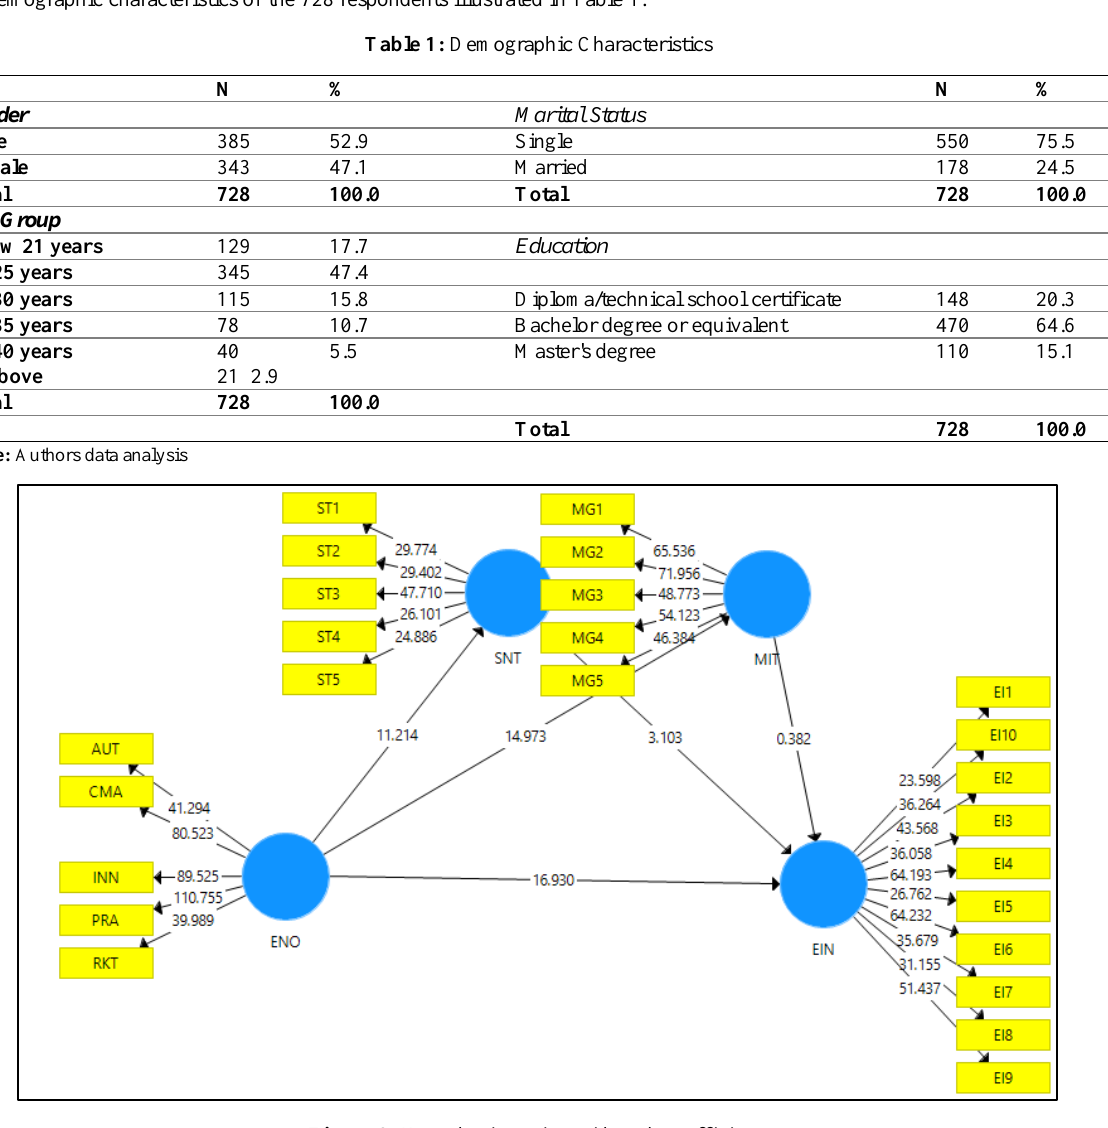
Figure 2: Hypothesis testing with path